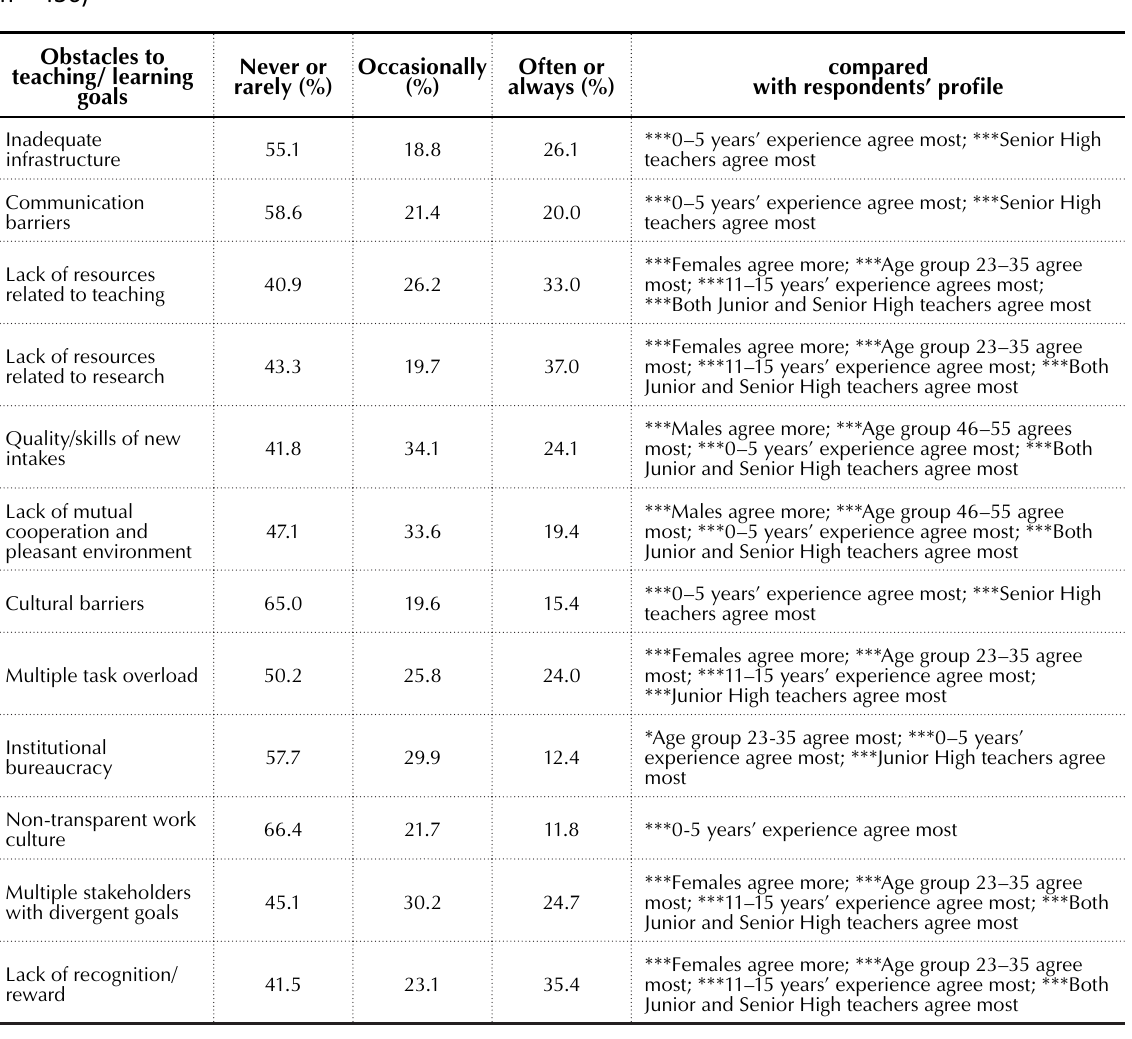
Table 6. Obstacles in meeting goals of teaching and learning, compared with respondents’ profile (n =